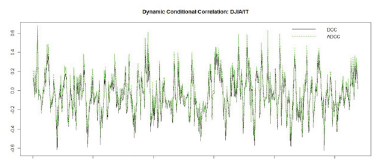
Fig. 8. Dynamic Conditional Corre- lation at D6 Scale